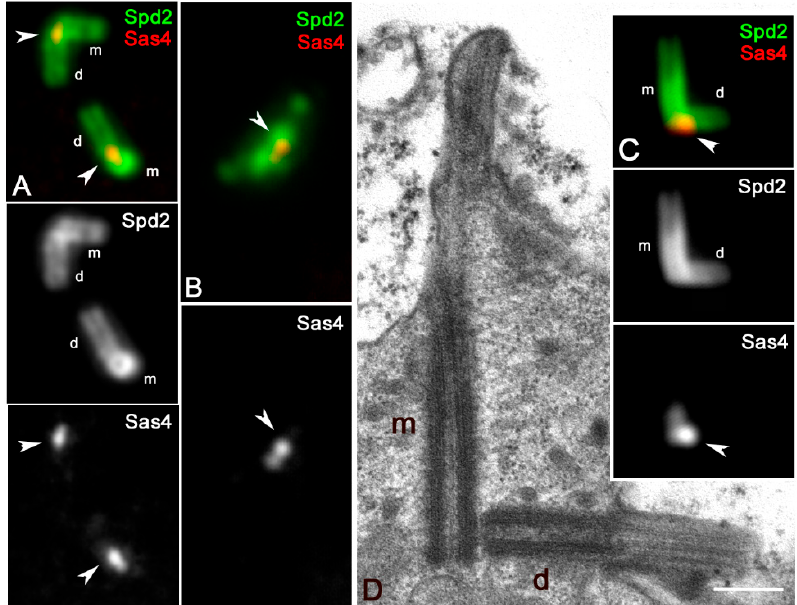
Figure 5. Localization of Sas4 in mature primary spermatocytes. ( A ) Detail of the centrioles in a mature primary spermatocyte in which it is possible to recognize mothers (m) and daughters (d) by their reciprocal orientation: Sas4 is more concentrated at the proximal ends of the daughter centrioles (arrowheads). ( B ) Detail of one centriole pair during the first metaphase showing that the asymmetric accumulation of Sas4 persists (arrow), but the parent centrioles are no longer distinguishable. ( C ) Longitudinal sections of the parent centrioles in Klp10A mutant primary prophase spermatocytes showing their asymmetric elongation. ( D ) The Sas4 brighter dot is associated with the shorter daughter centriole (arrowhead). m and d, are mother and daughter centrioles, respectively. Scale bar: ( A – C ), 1 µ m; ( D ), 200